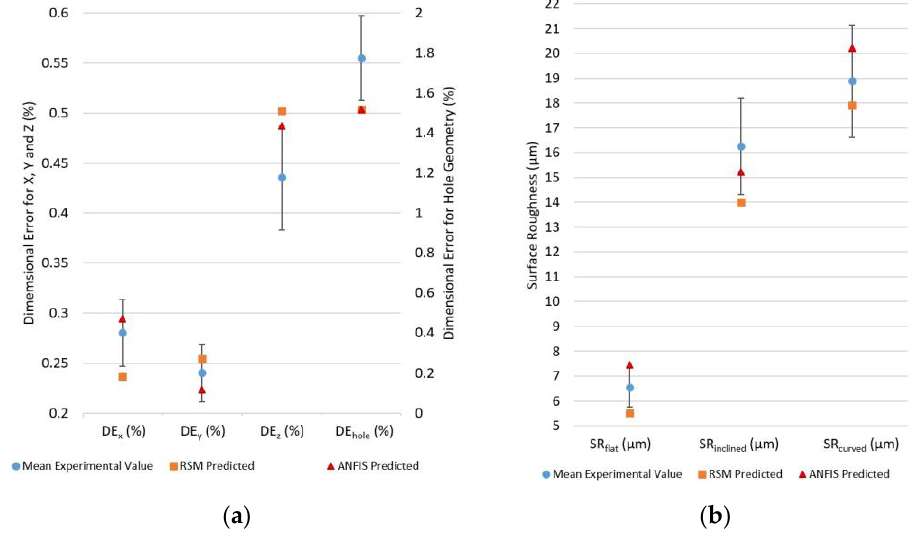
Figure 13. Error bars (uncertainty within ±12%) for experimental and predicted (RSM and ANFIS) values of ( a ) dimensional error response parameters and ( b ) surface roughness response parameters.